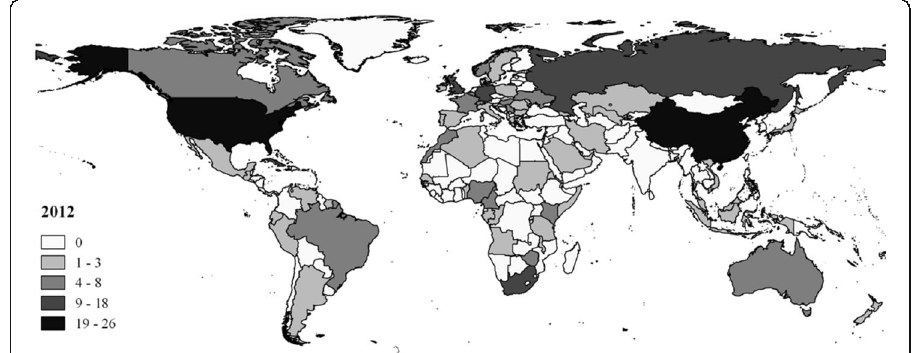
Fig. 2 Absolute no. of foreign athletes by country of birth (2012). Source: Authors ’ calculations and